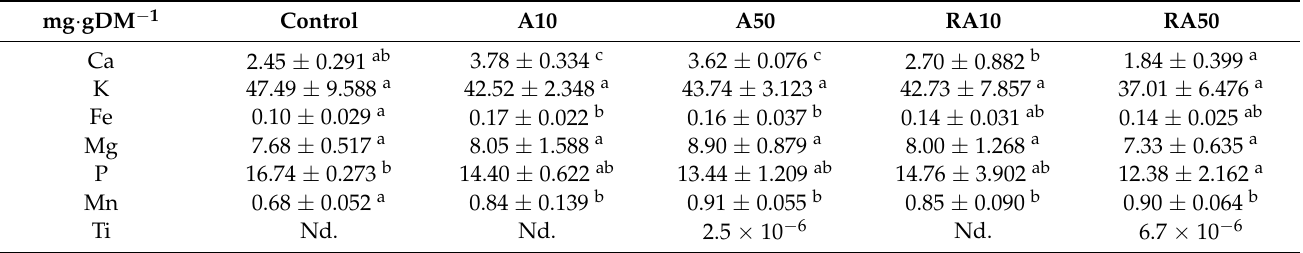
Table 3. Effects of A and RA treatments on leaf TiO 2 accumulation and composition of nutrients crucial for photosynthesis or osmotic balance. Nd.: not detected. Different letters mean significantly different values ( p < 0.05).